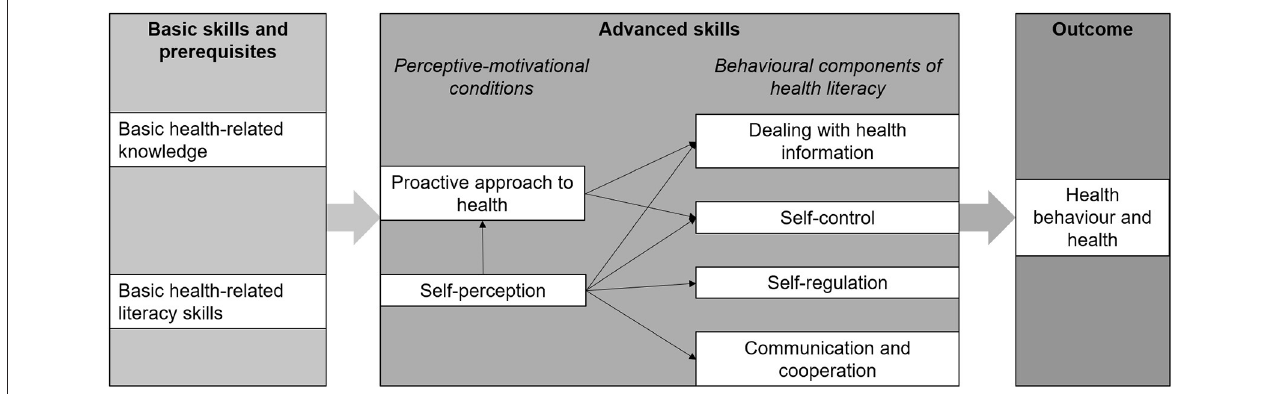
FIGURE 1 | Structural model of health literacy according to Lenartz (19) and Soellner et al.